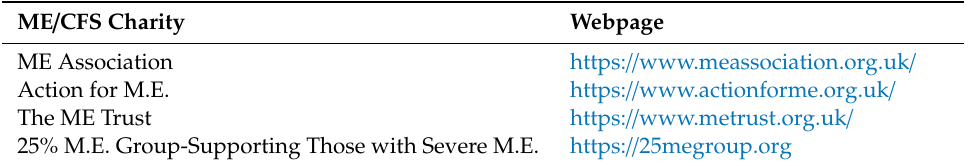
Table 2. Examples of UK charities providing guidance for healthcare practitioners and / or patient resources for ME /